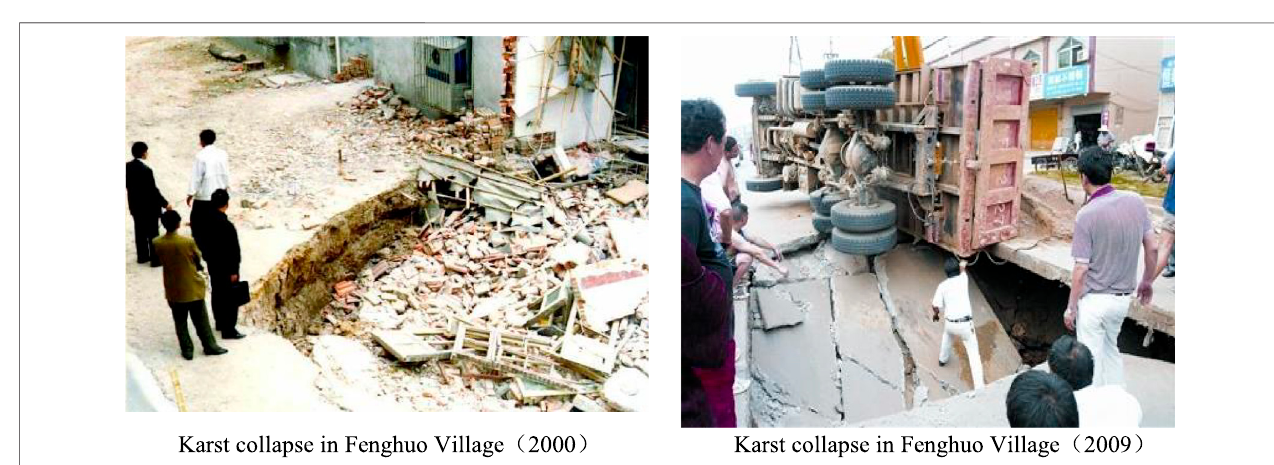
FIGURE 5 | Karst collapse incidents in Fenghuo Village. Karst collapse in Fenghuo Village (2000), Karst collapse in Fenghuo Village (2009).